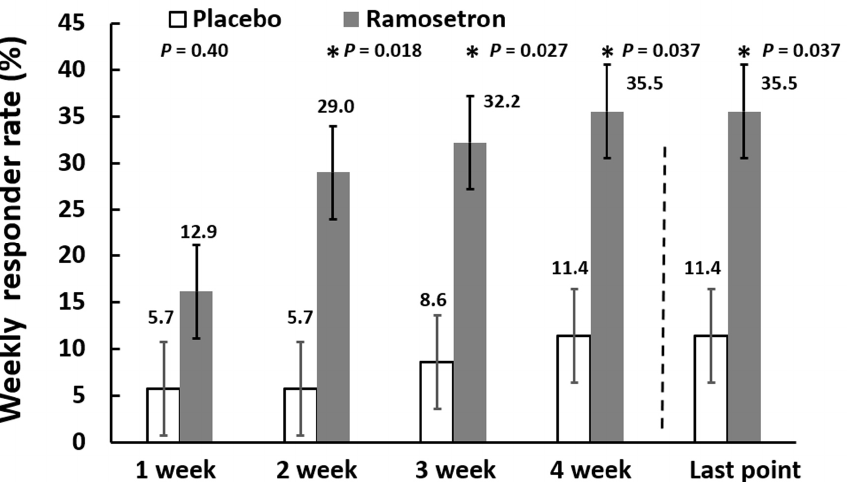
Figure 3 . Weekly responder rates for relief of overall IBS-D-like symptoms. Results are expressed as mean ± SD. * p < 0.05 vs. placebo. mean ± SD. * p < 0.05 vs. placebo.